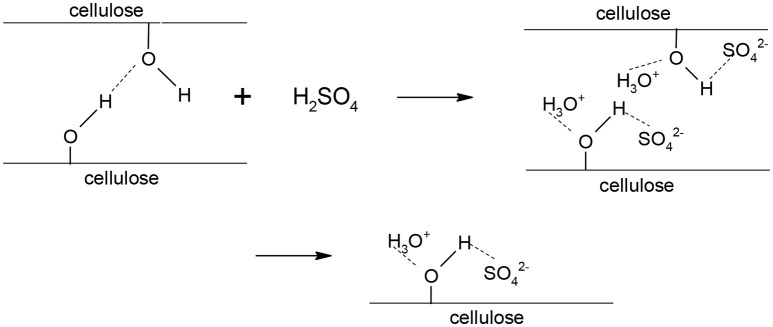
Dissolution mechanism of cellulose in 72 wt% sulfuric acid (based on Feng and Chen, 2008).